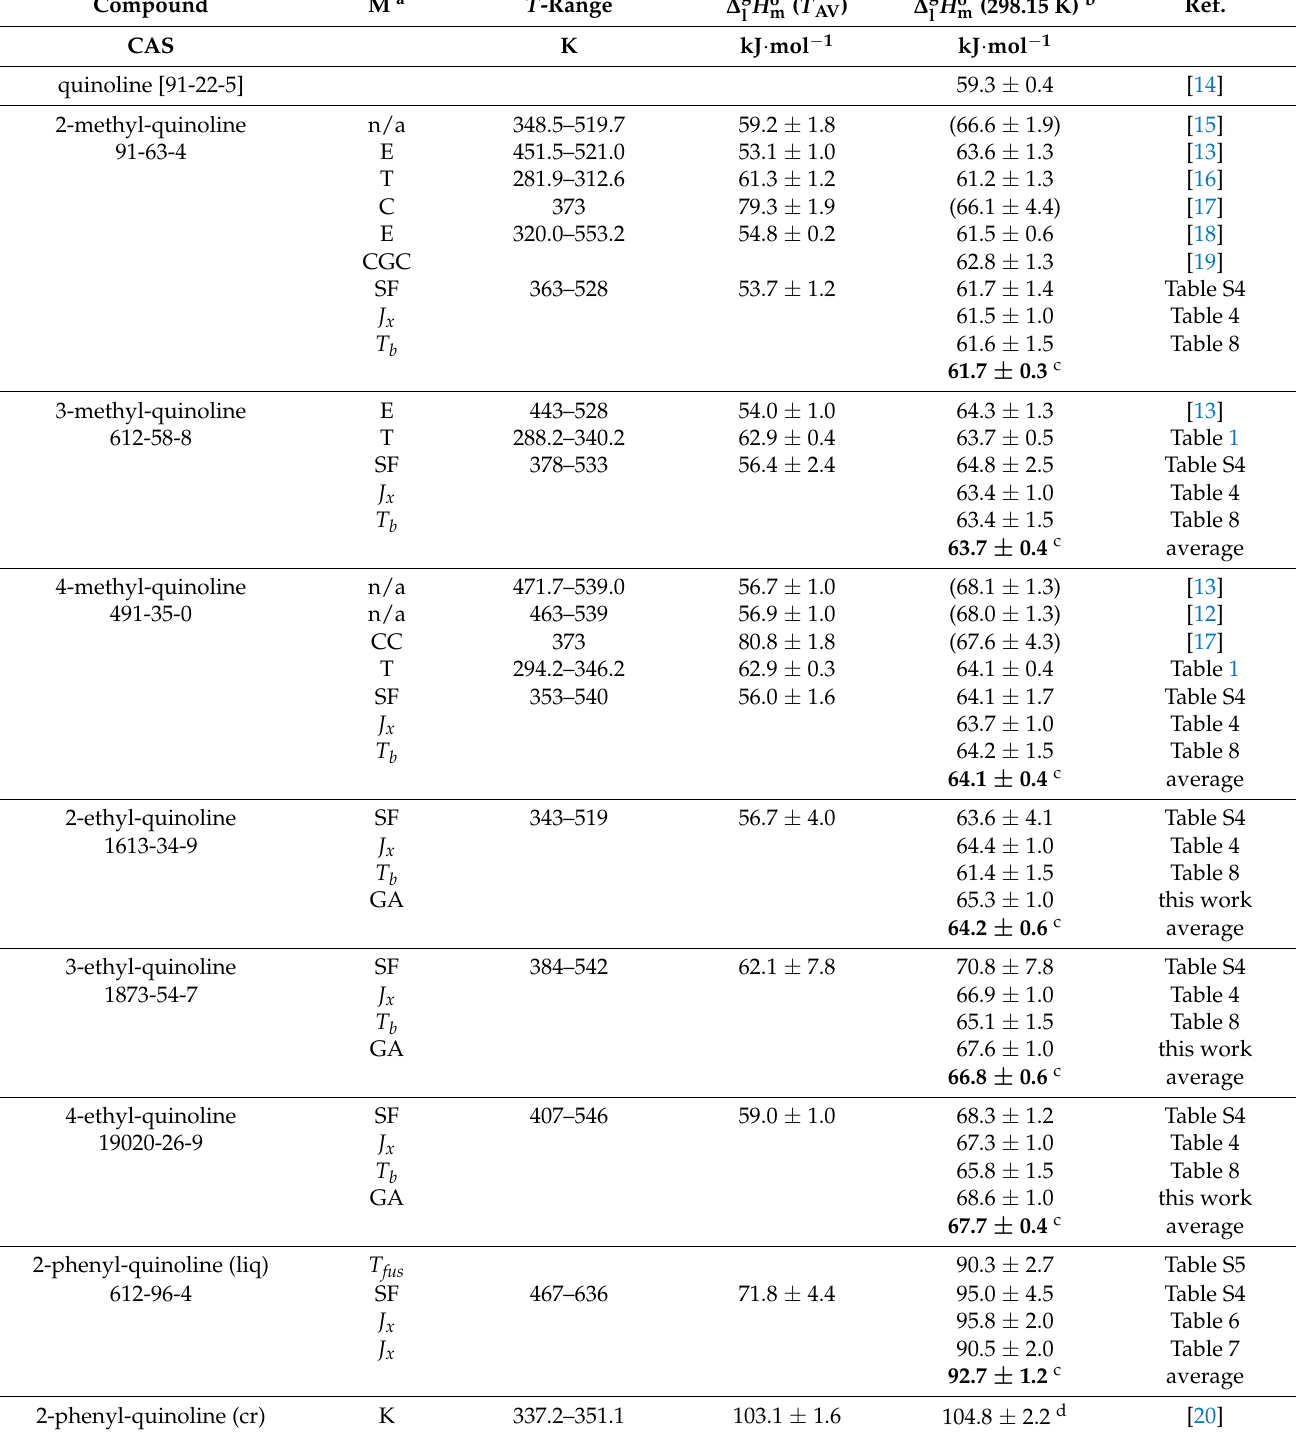
H o m , for the quinoline l